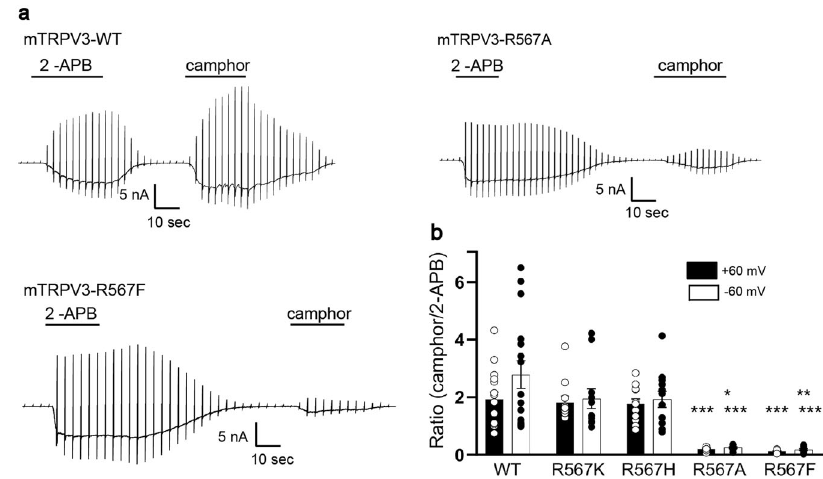
Fig. 5 Positive charge of R567 is essential for camphor-evoked activation of mouse TRPV3. a Representative current traces for HEK293T cells expressing WT, mTRPV3-R567A, or mTRPV3-R567F in response to 2-APB (300 μ M) treatment followed by camphor (10 mM) stimulation. b Comparison of normalized current densities ( I camphor / I 2-APB ) in HEK293T cells expressing WT, mTRPV3-R567K, mTRPV3-R567H, mTRPV3-R567A, or mTRPV3-R567F at ±60 mV (WT: 1.93 ± 0.25 at + 60 mV and 2.79 ± 0.48 at − 60 mV, n = 16; R567K: 1.82 ± 0.22 at + 60 mV and 1.95 ± 0.34 at − 60 mV, n = 11; R567H: 1.77 ± 0.17 at + 60 mV and 1.92 ± 0.28 at − 60 mV, n = 12; R567A: 0.21 ± 0.02 at + 60 mV and 0.25 ± 0.03 at − 60 mV, n = 9; R567F: 0.13 ± 0.01 at − 60 mV and 0.18 ± 0.03 at − 60 mV, n = 12). Holding potentials were − 60 mV with ramp-pulses ( − 100 to + 100 mV, 300 ms) applied every 3 s. Data represent means± SEM. Statistical analysis was performed by one-way ANOVA, * p < 0.05 (R567A vs. R567K, R567H at − 60 mV), ** p < 0.01 (R567F vs. R567K, R567H at − 60 mV) and *** p < 0.001 (R567A vs. WT, R567K, R567H at + 60 mV; R567F vs. WT, R567K, R567H at + 60 mV; R567A vs. WT at − 60 mV; R567F vs. WT at − 60